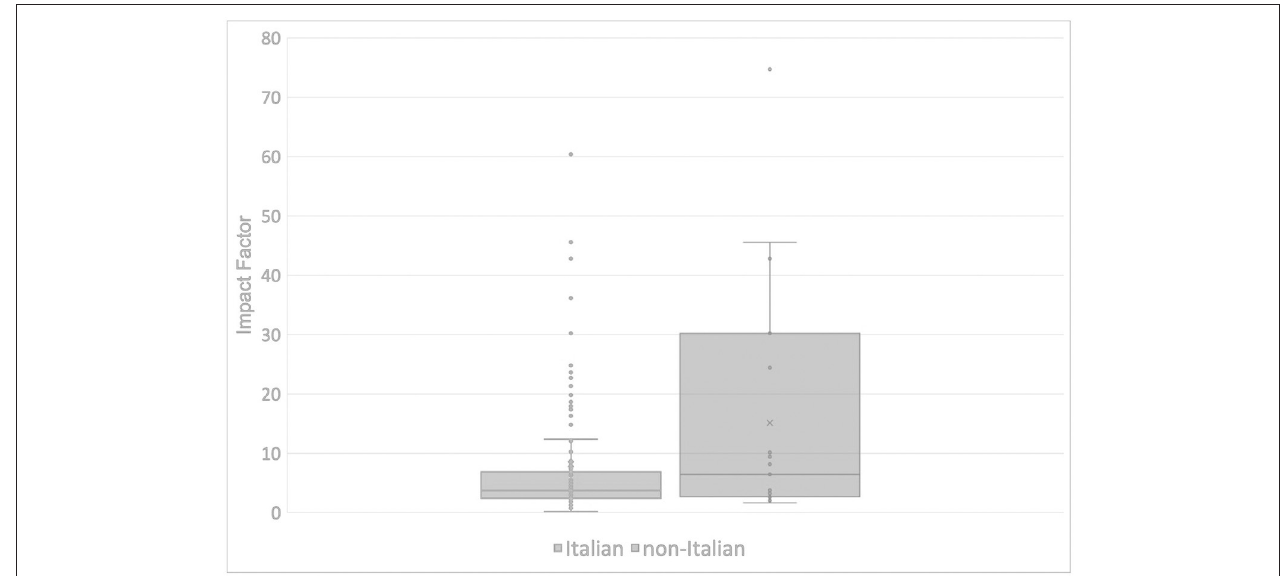
FIGURE 5 | Distribution of Impact Factor of the journals that published Italian (left) and non-Italian (right) articles.